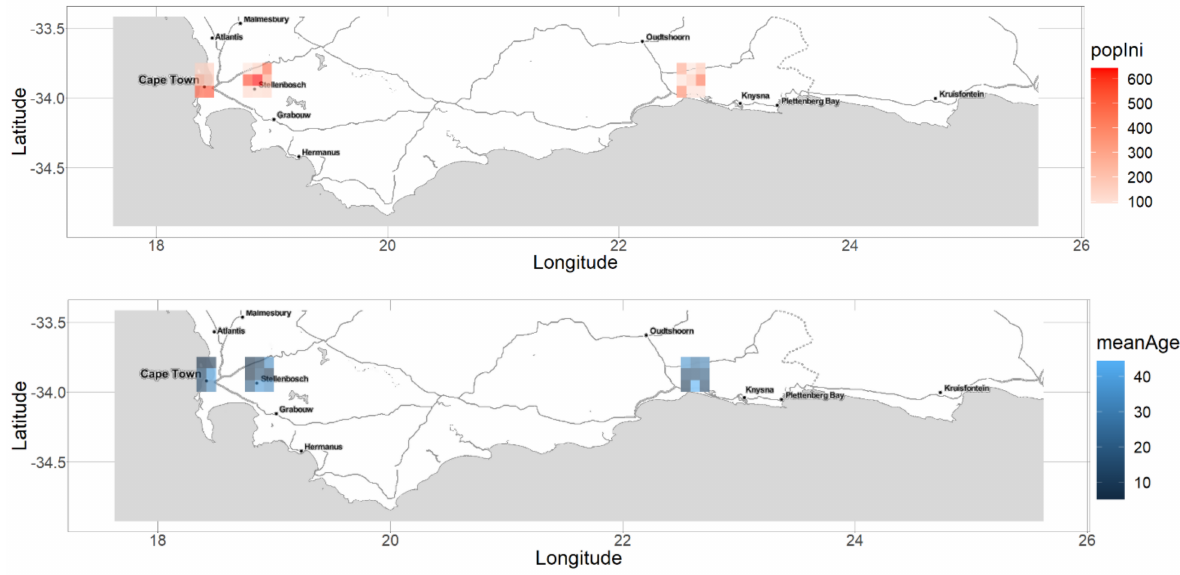
Figure 1. Maps of estimated mean population sizes and ages in the initial year 1980. Top: Mean posterior estimate of population size across the introduction cells. Bottom: Mean posterior estimate of the mean population age across the introduction cells. The associated posterior distributions are provided in Figures A5 and A6 of Appendix